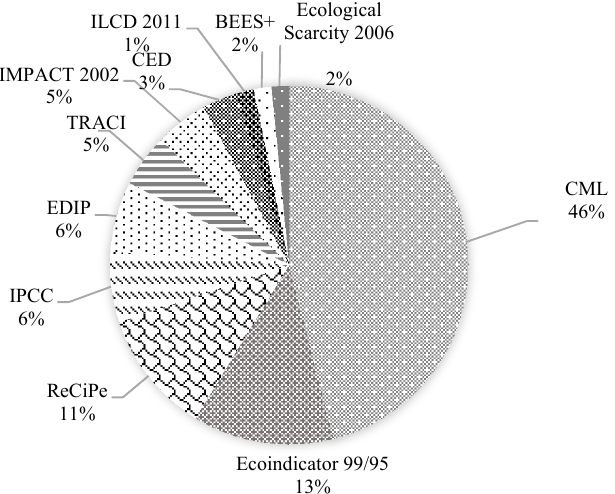
Figure 6. Share of most used assessment methods in previous LCA studies.